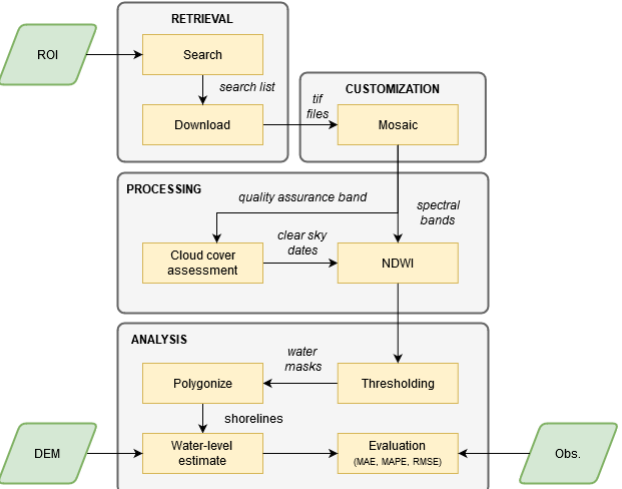
Figure 2. Workflow diagram of the approach in the case study of the Itoiz reservoir. The workflow is divided into four steps (grey zones); retrieval, customization, processing, and analysis. Steps 1–3 show the main capabilities of RGISTools . Step 4 illustrates other analytical tools R . Green squares represent the information inputs, where ROI stands for the region of interest, DEM for digital elevation model, and Obs. for in situ observations of the water levels. The evaluation was carried out using the mean absolute error (MAE), the mean absolute percentage error (MAPE), and the root mean squared